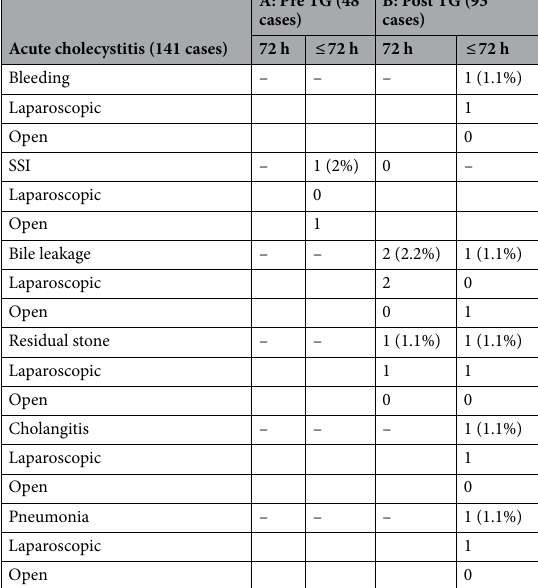
Acute cholecystitis (141